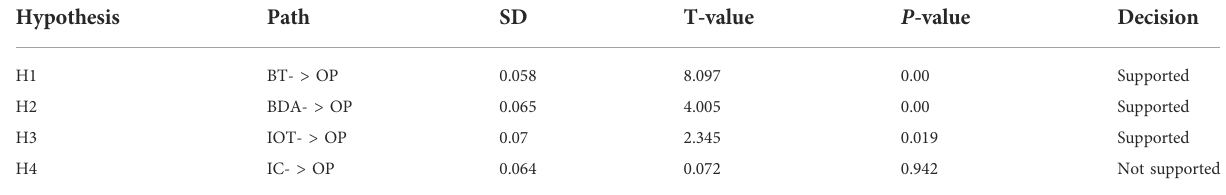
TABLE 6 Direct path testing.